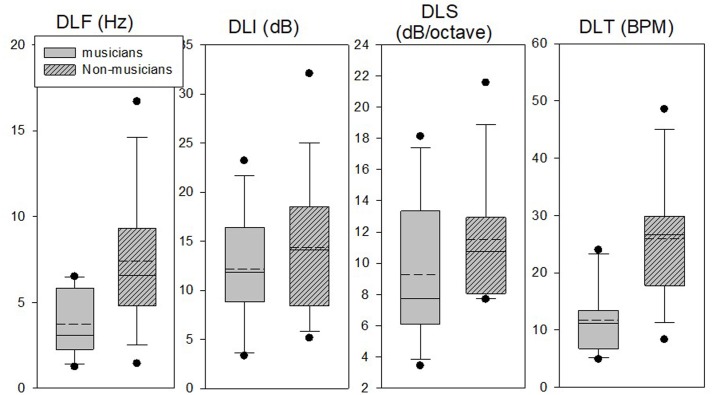
Box plots of the mean last two measurements (4 and 5) in the DLF, DLI, DLS, and DLT tasks for the musicians and non-musicians. Box limits include the 25th–75th percentile data. Continuous line within the box represents the median. Dashed line within the bars represents mean. Bars extend to the 10th and 90th percentiles. Black dots represent outliers.